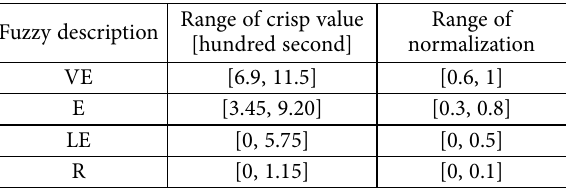
Table 4. Fuzzy classification of